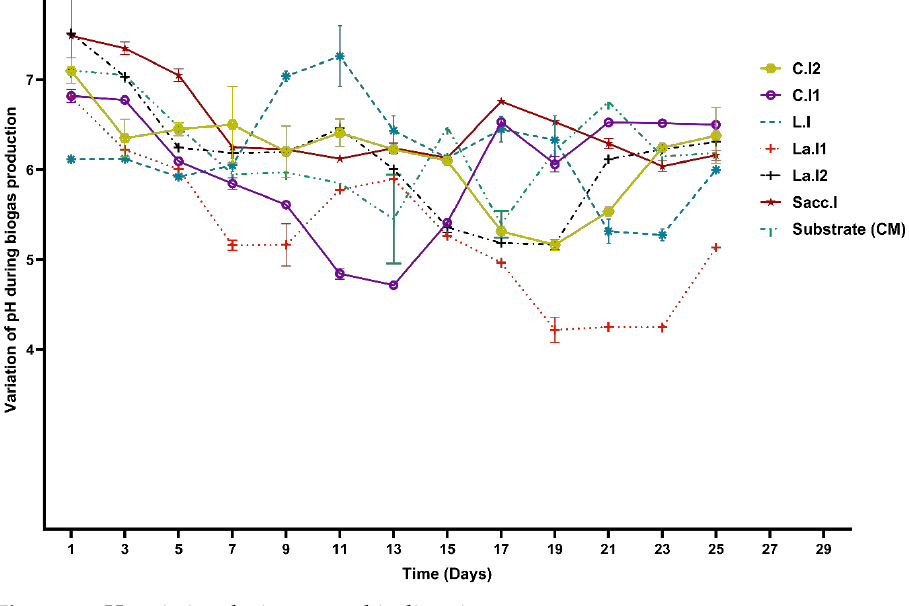
Figure 1. pH variation during anaerobic digestion